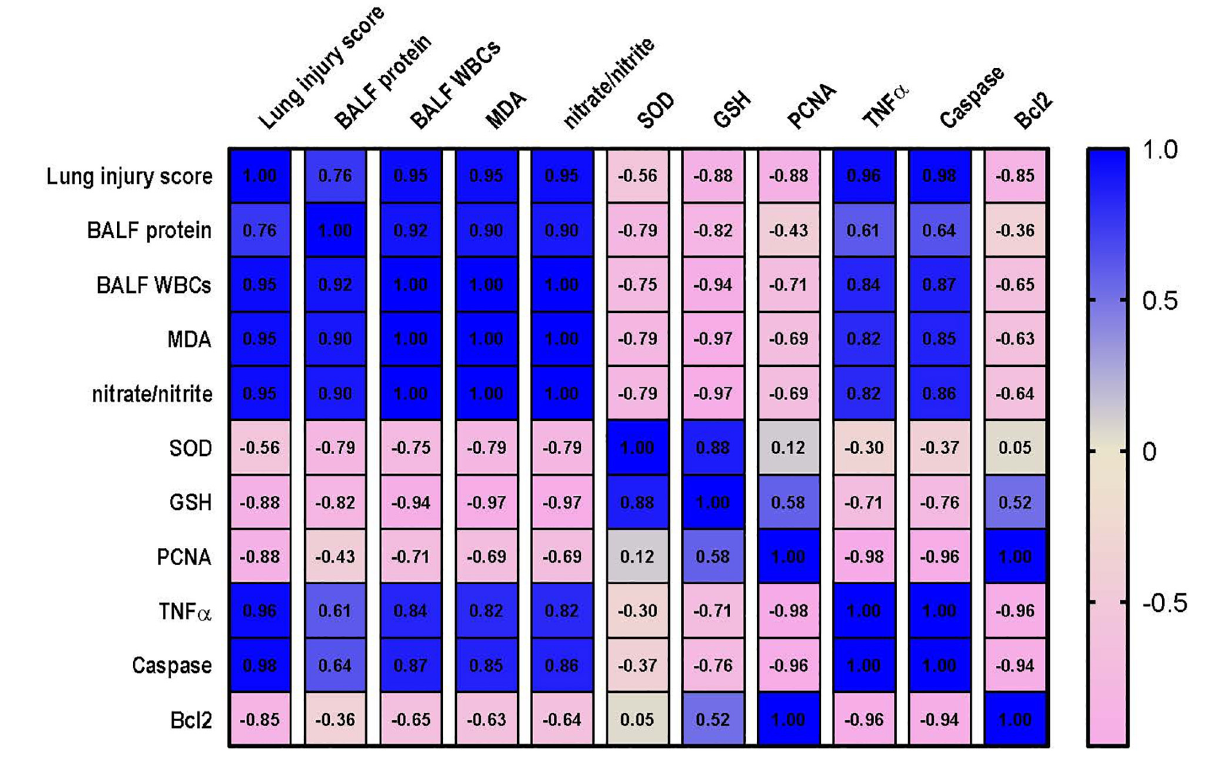
FIGURE 10 | Correlation analysis of lung injury and measured parameters. Correlation matrix between lung injury score and related parameters. Data from different experiments were analyzed for correlation using the Pearson correlation coefficient (r). Positive values indicate a positive correlation while negative values indicate a negative one. When r is in the range of | 0.3| –| 0.7|, this indicates a moderate correlation, and when r > | 0.7|, this means a strong correlation. BALF, bronchoalveolar lavage fluid; MDA, malondialdehyde; SOD, superoxide dismutase; GSH, reduced glutathione; PCNA, proliferating cell nuclear antigen; TNF– α , tumor necrosis factor α ; Bcl2, B cell lymphoma